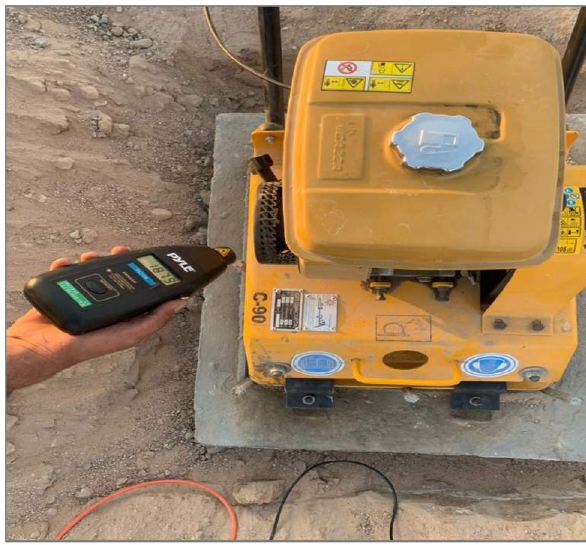
Figure 2: Measurement of the generated